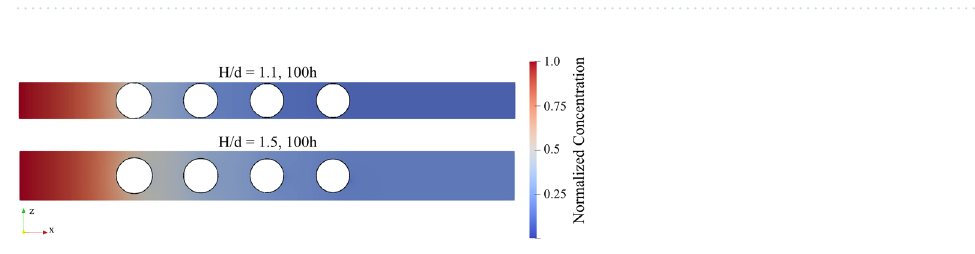
Figure 7. Mass of precipitated solid phase in whole domain as a function of nondimensional time for different geometrical constrains H/d and Pe .